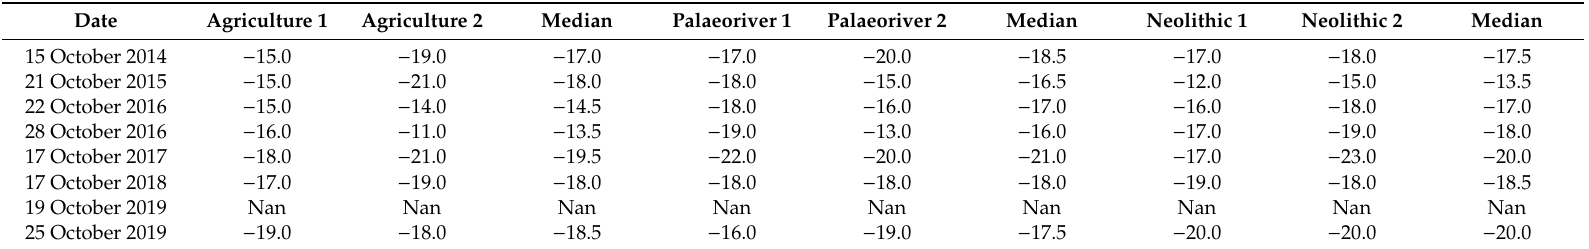
Table A6. Backscatter values for the Sentinel 1 2014, 2015, 2016, 2017, 2018, and 2019 Sigma0 − VH